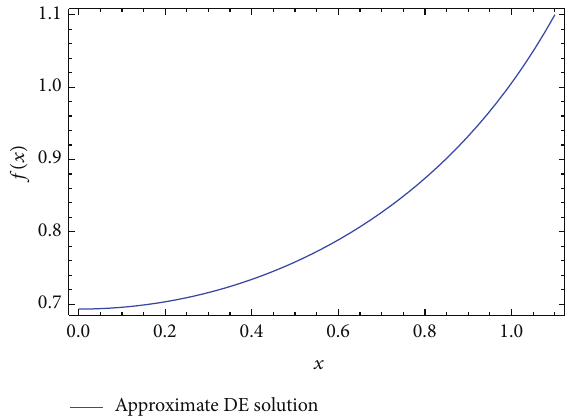
Figure 4: Approximate solution for 𝑦 󸀠󸀠 −𝑦𝑦 󸀠󸀠 −0.5𝑦 󸀠2 −0.5 = 0 with 𝑦(0) = 0 and 𝑦(1) = −0.5 . Figure 5: Approximate solution for 𝑦 󸀠󸀠 − 2𝑦 4 = 0 with 𝑦(1) = 1 and